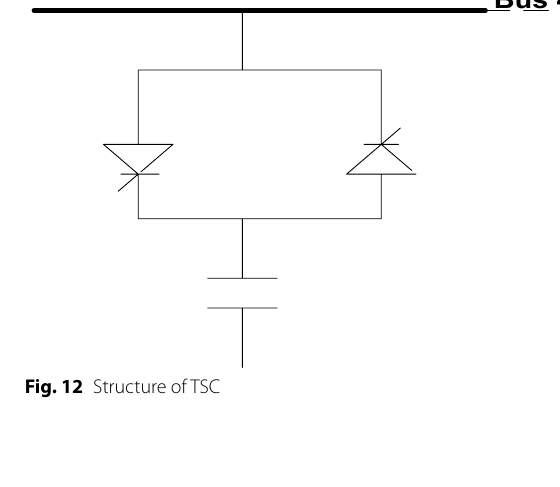
Table 17 THD of real power flow with and without TCSC for IEEE 57- bus system at buses 9 and 10 Bus No THD (%) without TCSC THD (%)